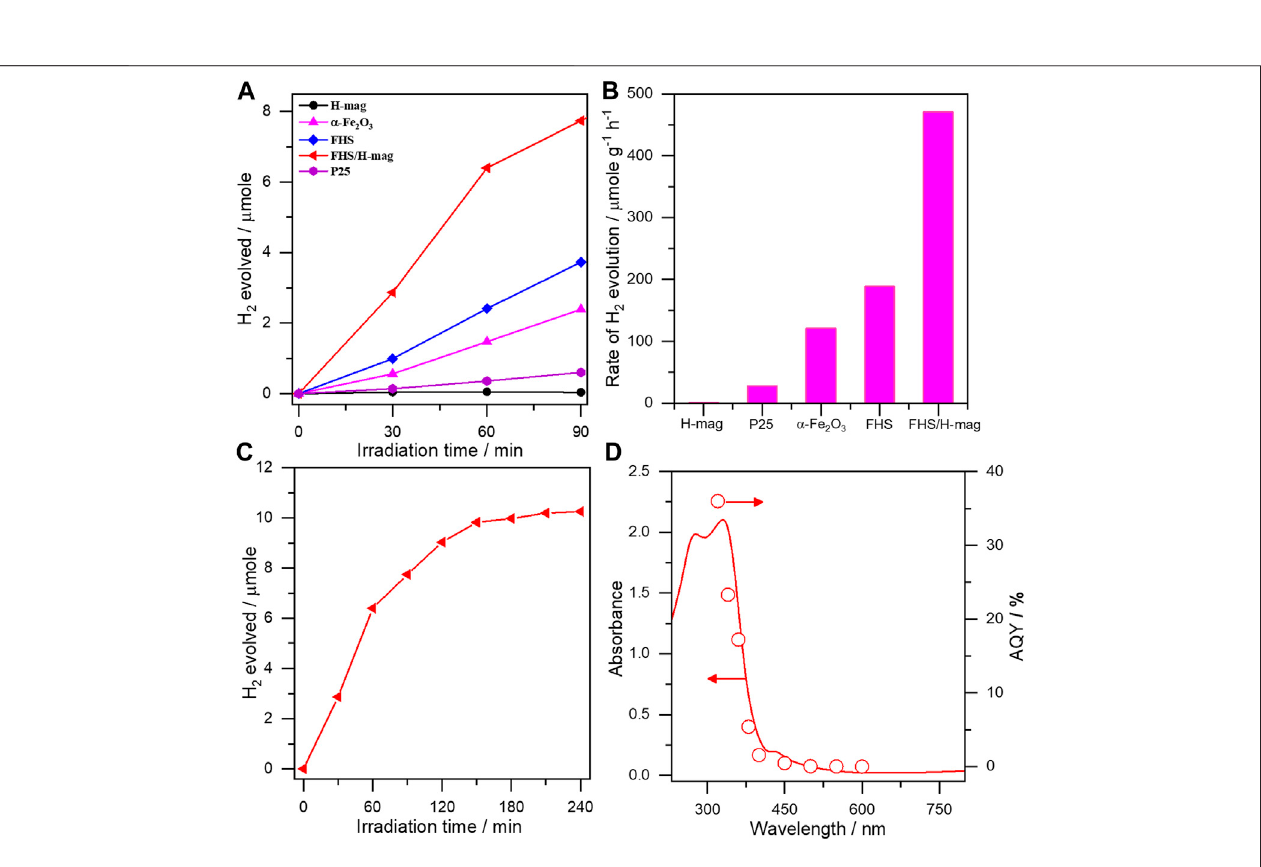
Frontiers in Energy Research |